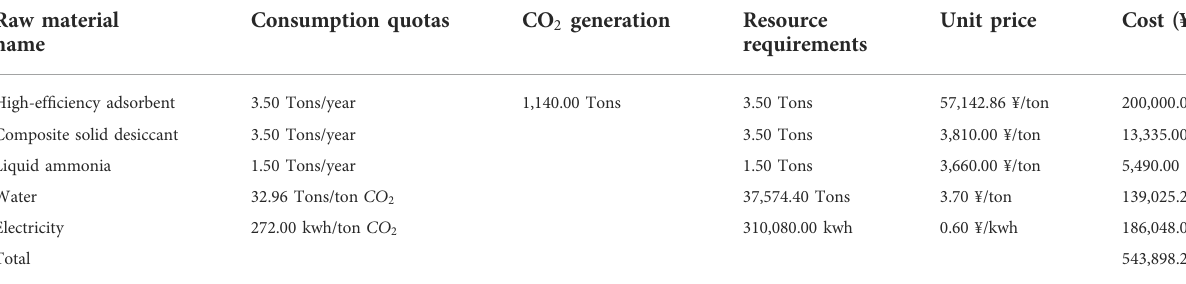
TABLE 8 Increased consumption of raw materials under scenario